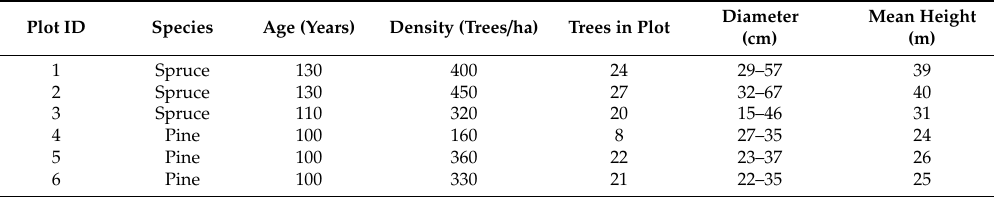
Table 1. Parameters of forest stands containing research